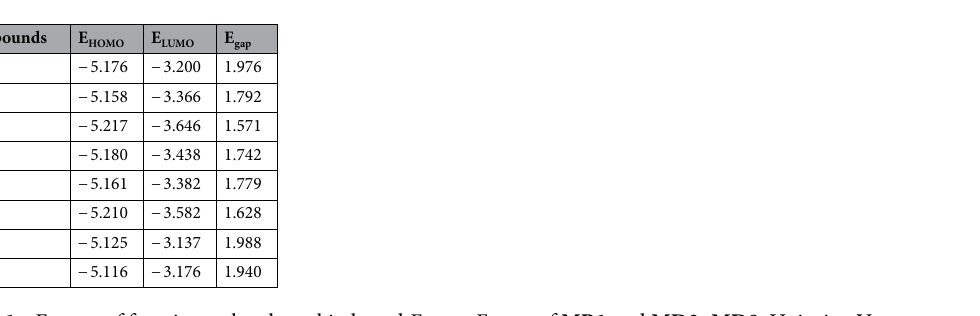
Table 1. Energy of frontier molecular orbitals and E LUMO – E HOMO of MR1 and MD2–MD8 . Units in eV.